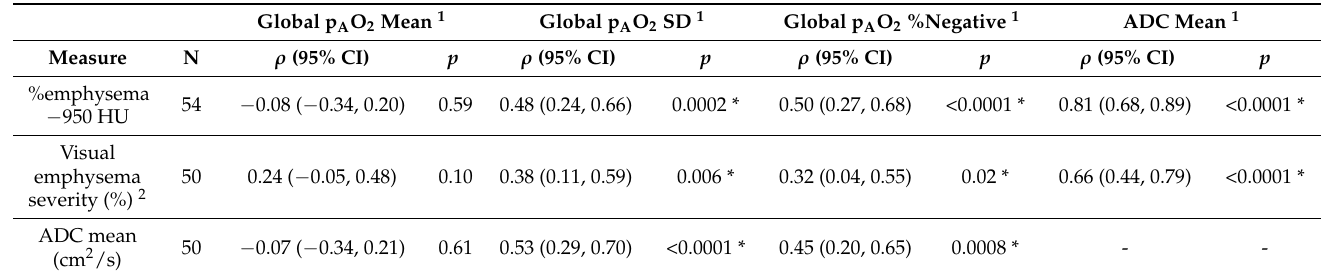
Table 3. Spearman’s correlation coefficients between emphysema measures and p A O 2